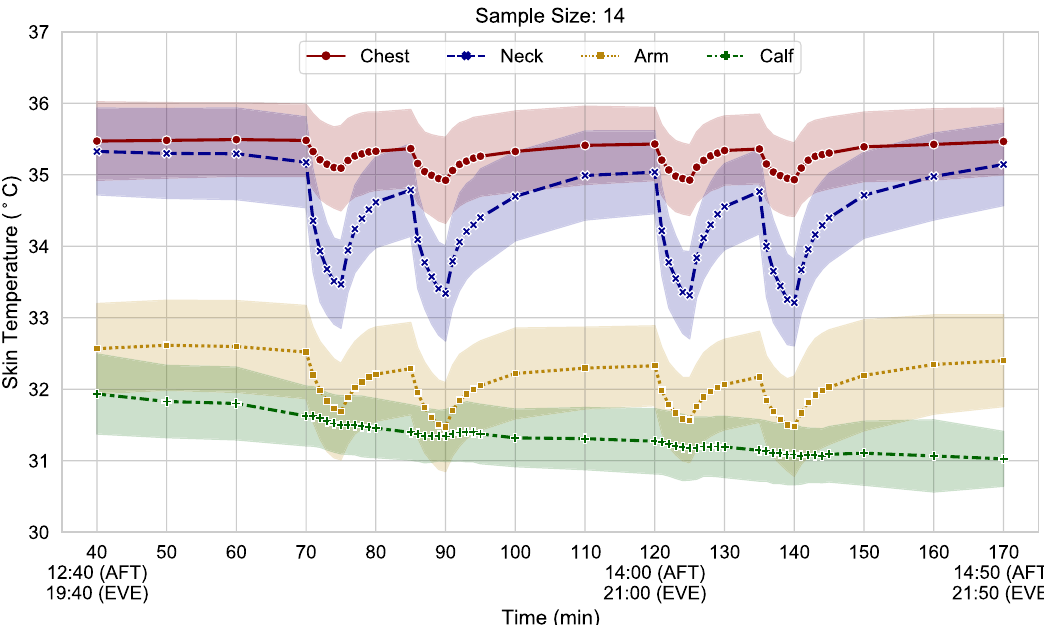
Figure 3. Skin temperature over the course of the experiment at 4 different locations (chest, neck, arm, and calf). Shaded bands represent one standard